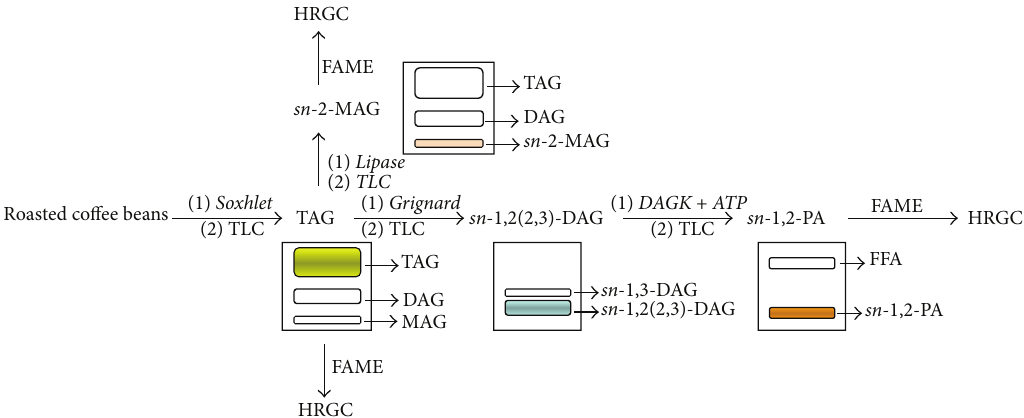
Figure 1: Scheme of the procedure used for TAG stereospecific